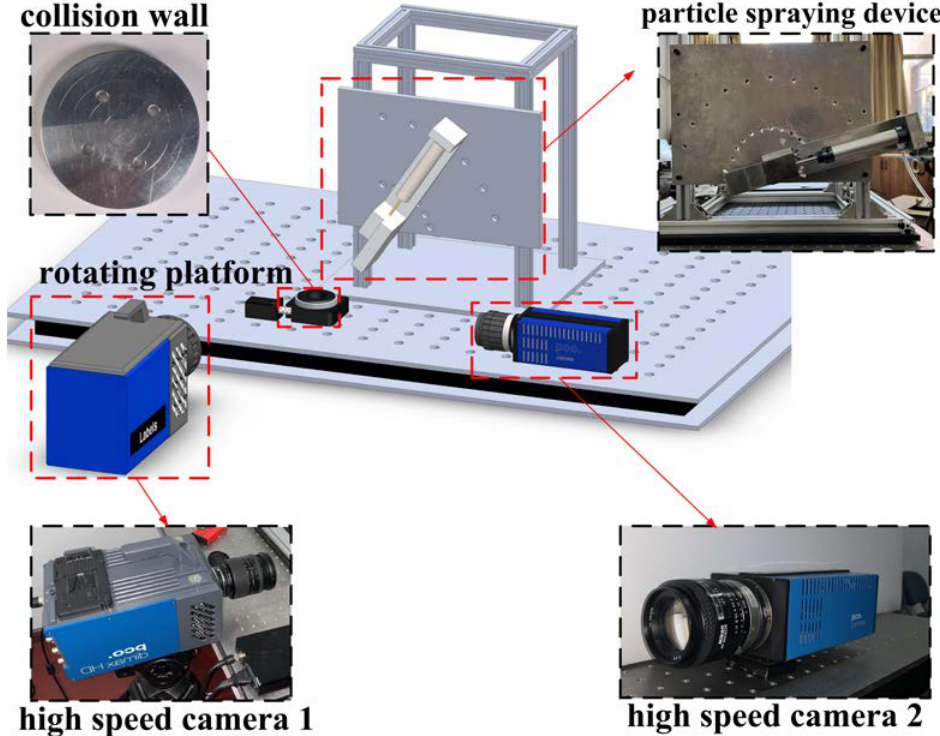
Figure 1. Flowchart for correcting the roll forming process design.